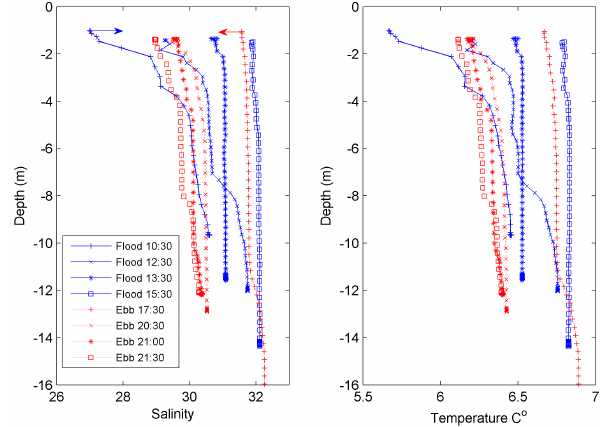
Figure 7. Samples of salinity and temperature profiles in the Hilbre Channel during the 14 February 2008. The arrows show the direc- tion at which the profile moves at the start of flood (blue) and ebb